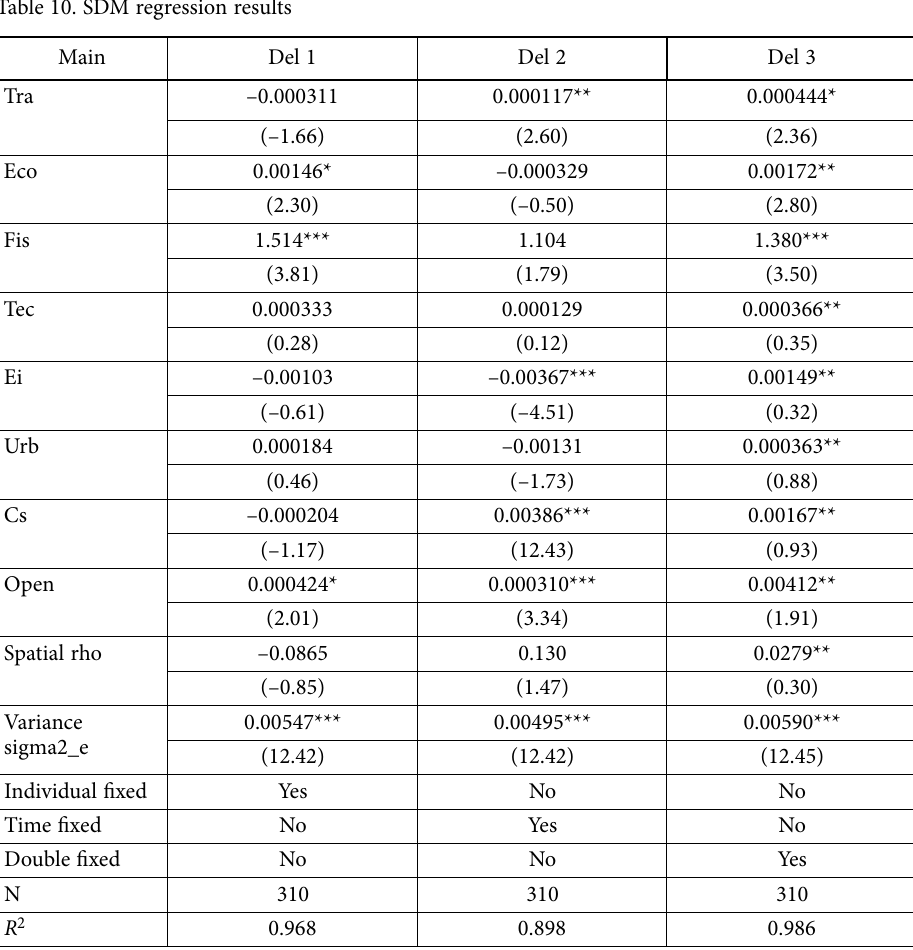
Table 10. SDM regression